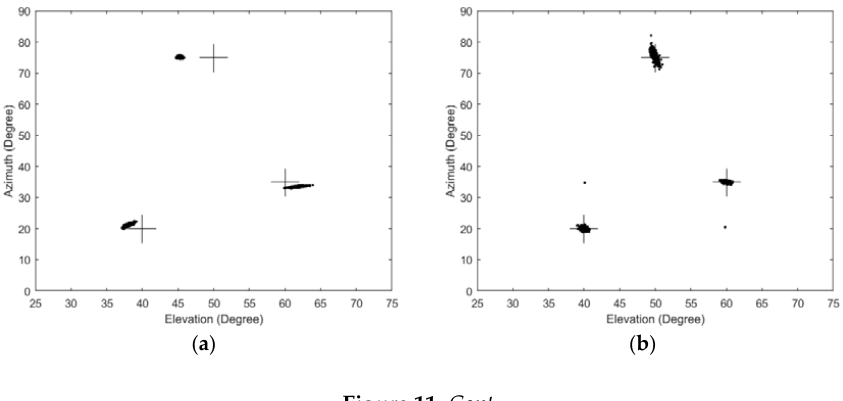
Figure 11. Cont. Figure 11.